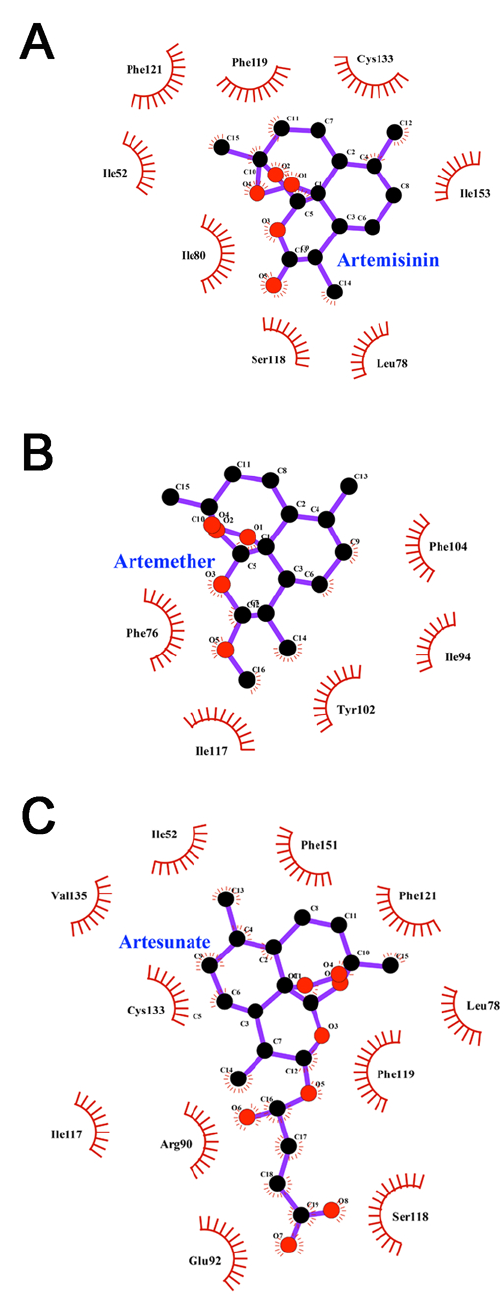
Figure 7. Interactions of MD-2 with ( A ) artemisinin, ( B ) artemether and ( C ) artesunate. The last frame of the MD simulation was used for these